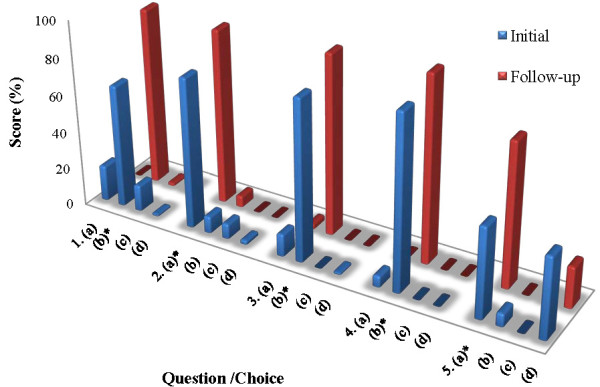
Initial and follow-up responses (n = 67).